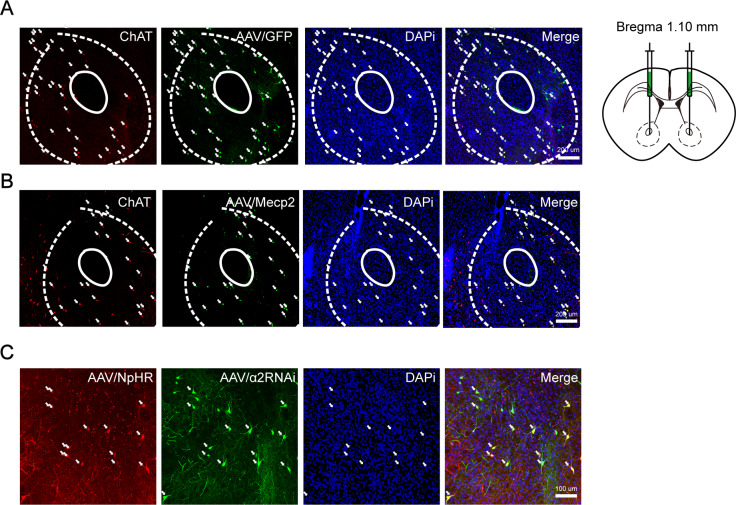
Systemic Delivery of Various AAV Vectors into NAc, Related to Figures 2, 4, 5.(A) Diagram of virus injection into NAc (right) of ChatCre mice and confocal image of AAV/GFP vector-injected NAc slice demonstrating colocalization of GFP expression with ChAT antibody, co-stained with DAPI (left). (B) Confocal image of AAV/Mecp2 vector-injected NAc slice demonstrating colocalization of GFP expression with ChAT antibody, co-stained with DAPI. (C) Confocal image of AAV/NpHR and AAV/α2 RNAi vector-injected NAc slices demonstrating colocalization of mCherry expression with GFP expression, co-stained with DAPI.